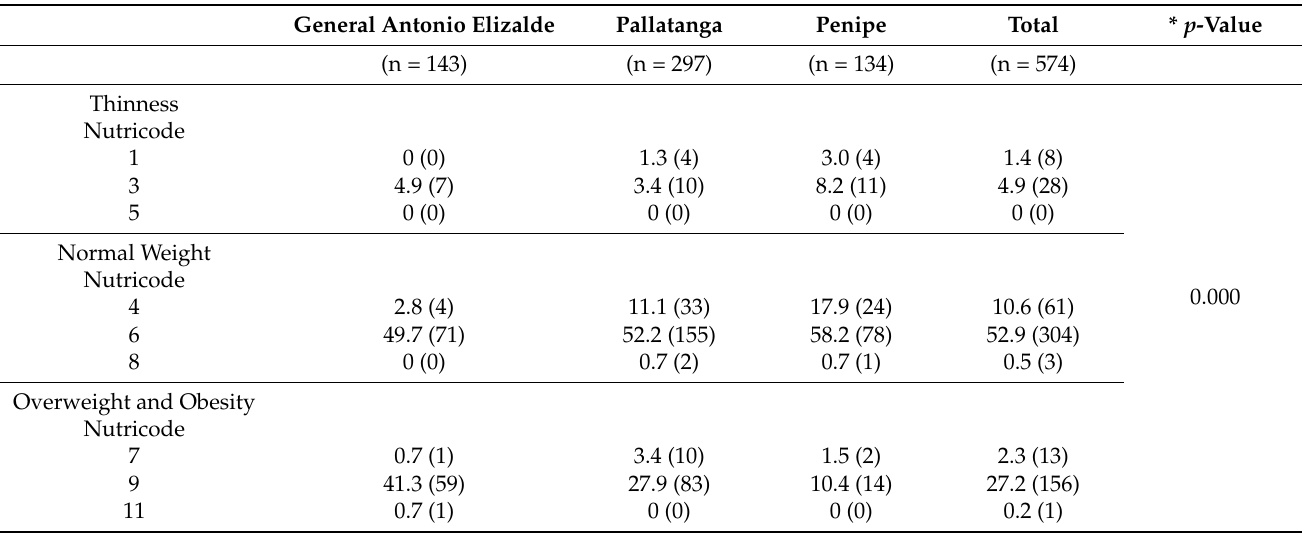
Table 5. Frequencies (%) of the studied population according to codes established for Nutrimetry stratified by